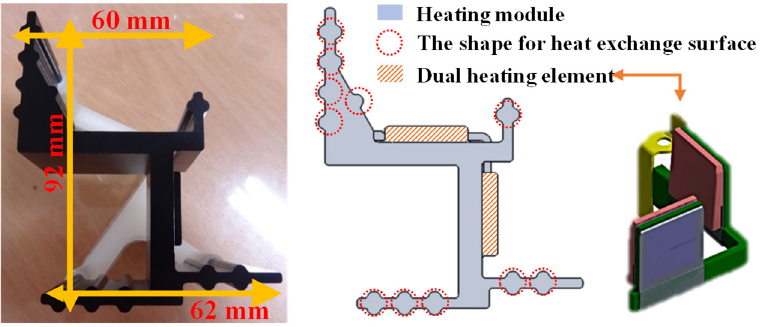
Figure 3. Heating module and heating elements.